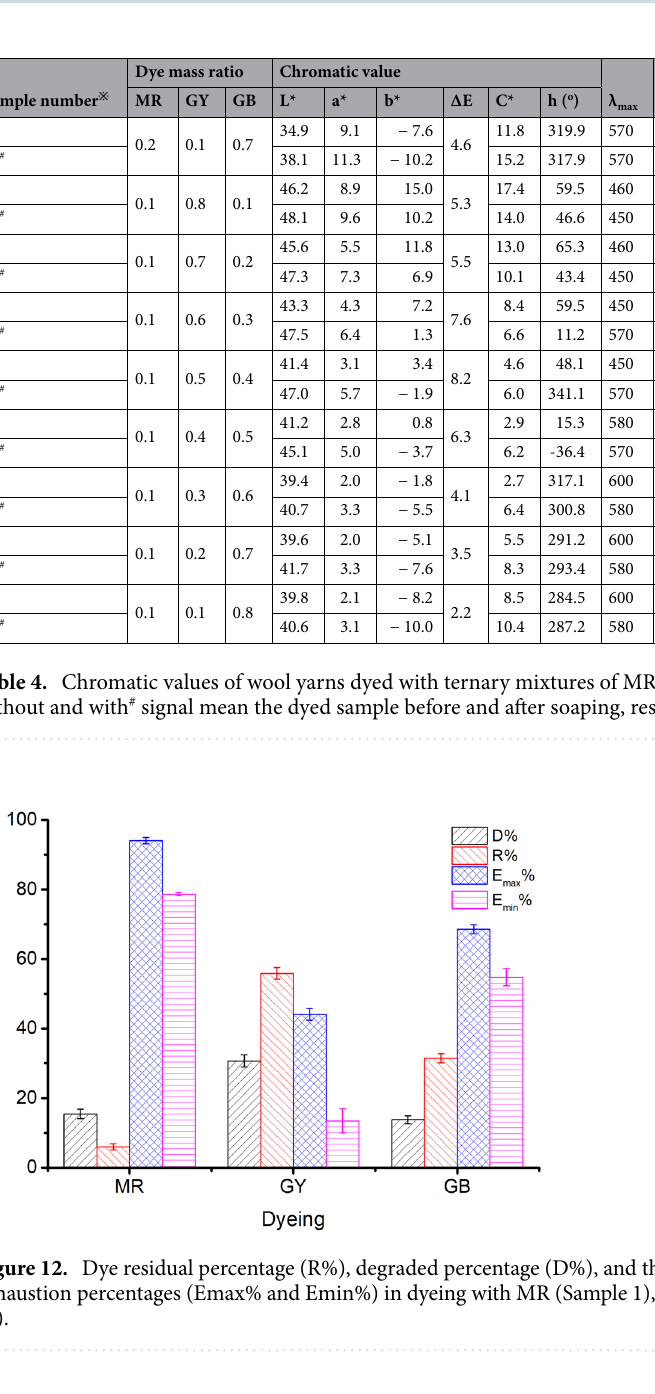
(red color) mainly contributes to the positive a* value, while GY (yellow color) mainly affects the positive b* value, according to the color coordinate. In Table 1, the dye mass ratio was 0.2:0.8 (MR:GY) for Sample 37. However, the λ max of K/S was 530 nm, and h was 33.5°, indicating that the main color hue of the sample is reddish. The photograph of Sample 37 in